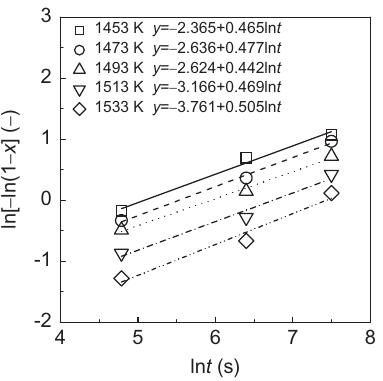
Figure 5: Relationship between holding time in natural logarithmic form ln t and ln ½ − ln ð 1 − x Þ(cid:3) for phosphate-enriched phase in CaO – SiO 2 – FeO – Fe 2 O 3 – P 2 O 5 steelmaking slags at temperatures of 1453, 1473, 1493, 1513 and 1533 K, respectively.